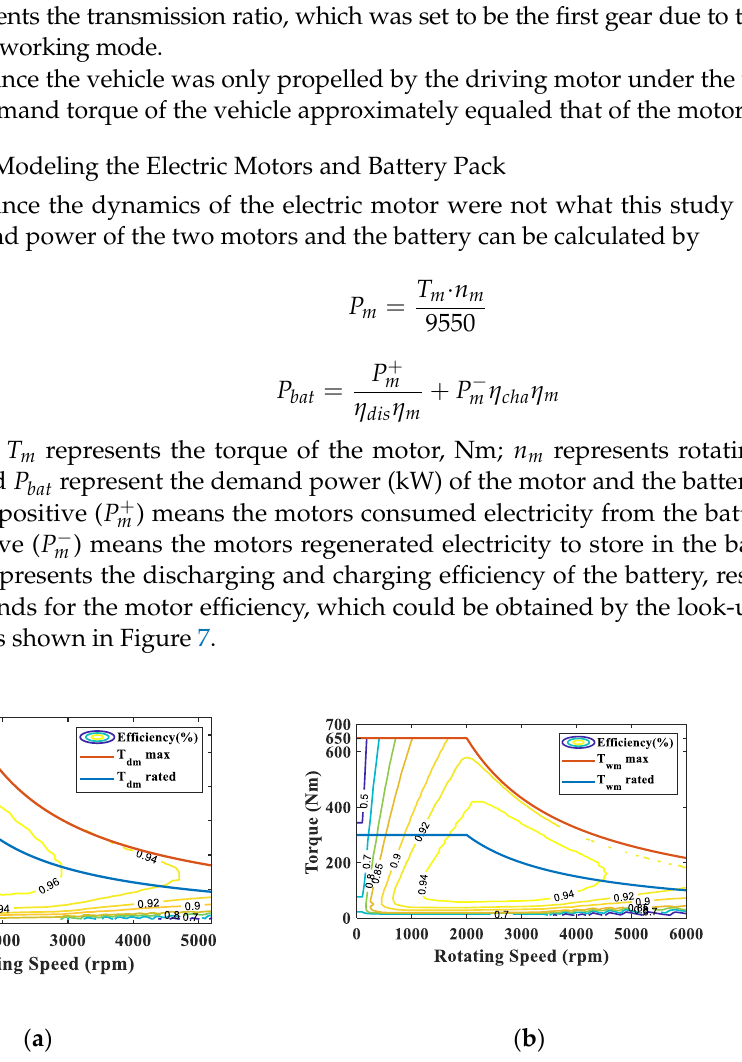
Figure 7. Efficiency map of the two motors: ( a ) the efficiency map of the driving motor and ( b ) the efficiency map of the working